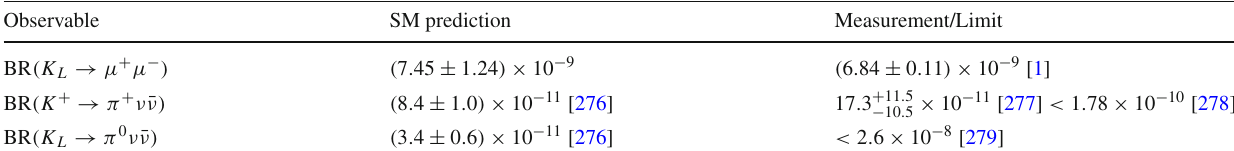
Table 13 Data on FCNC kaon decays. The SM predictions are obtained using flavio [199] if not otherwise stated Observable SM prediction